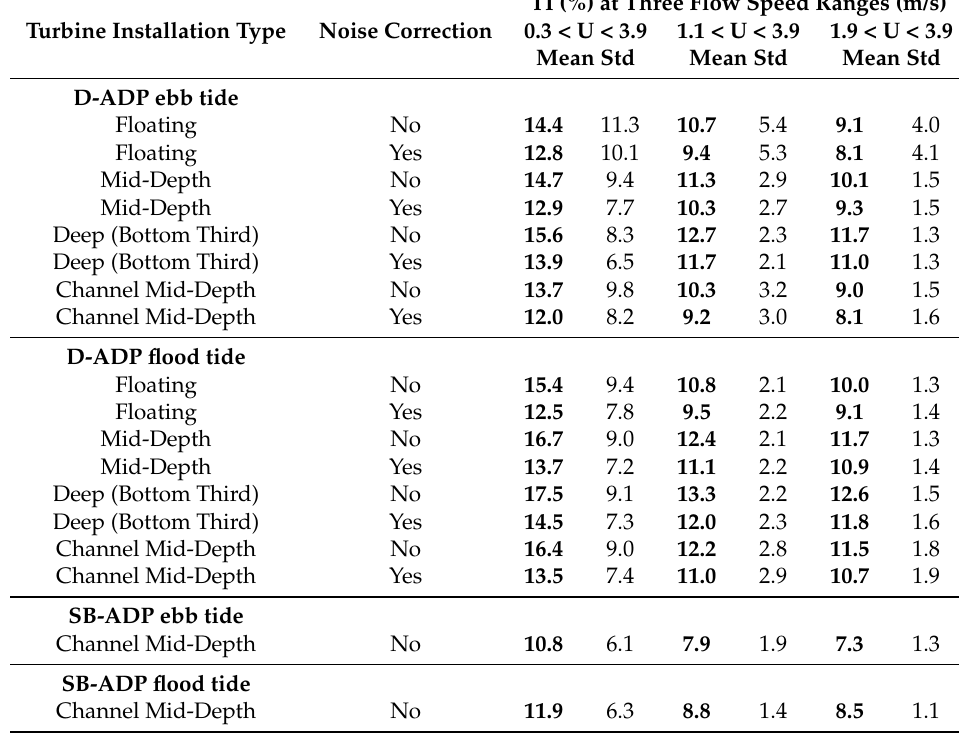
Table 6. TI with and without noise correction for differing TEC deployment depths. Std is the standard deviation derived spatially across the vertical